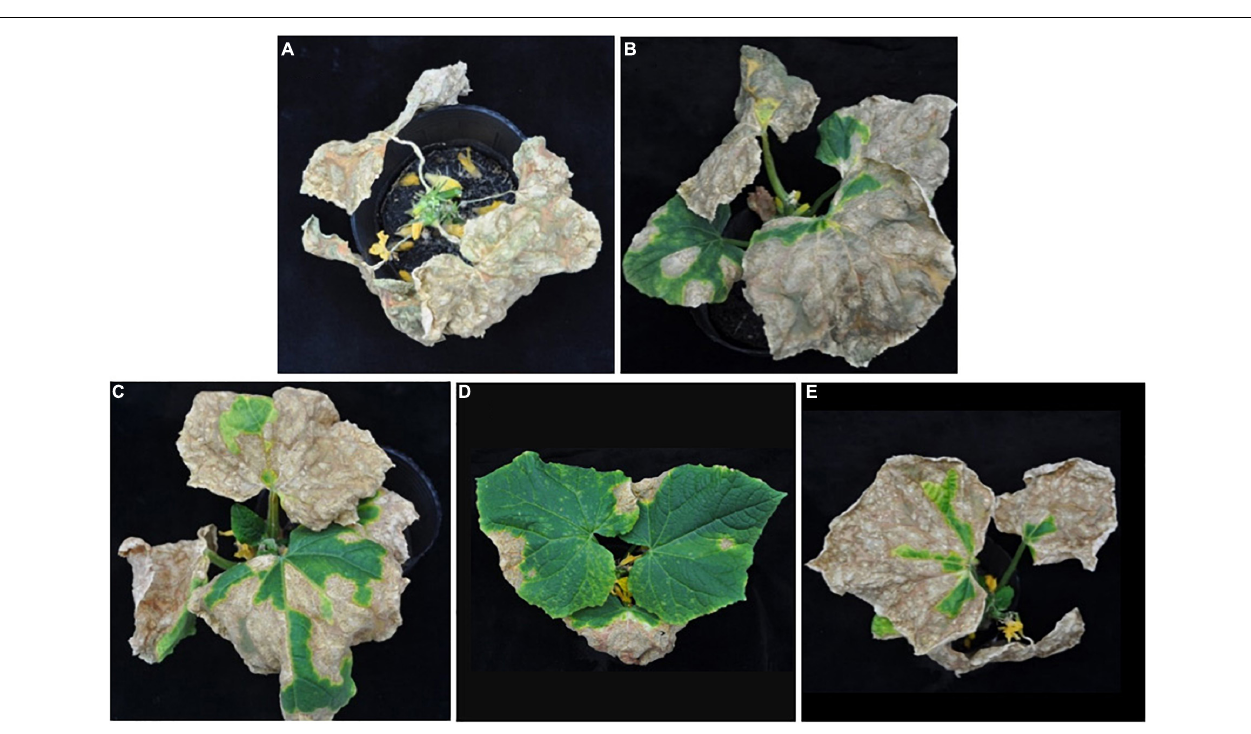
and S. asterosporus (AY999902), respectively ( Figure 3 ). Further identification of LJS06 based on MLSA revealed that LJS06 was clustered with S. griseorubiginosus strain AS 4.1766 T and